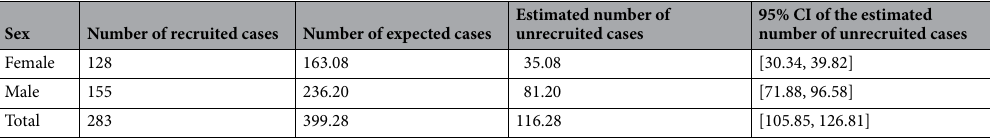
Table 1. Statistically estimated number of unrecruited ALS cases in Ohio during 2016–2018. The output from the Poisson regression model contains decimal digits.